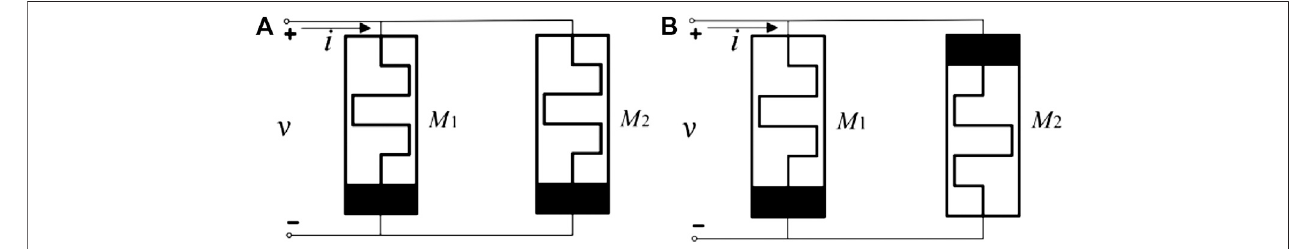
FIGURE 12 | Two parallel memristor circuits with (A) same polarities, and (B) opposite polarities.